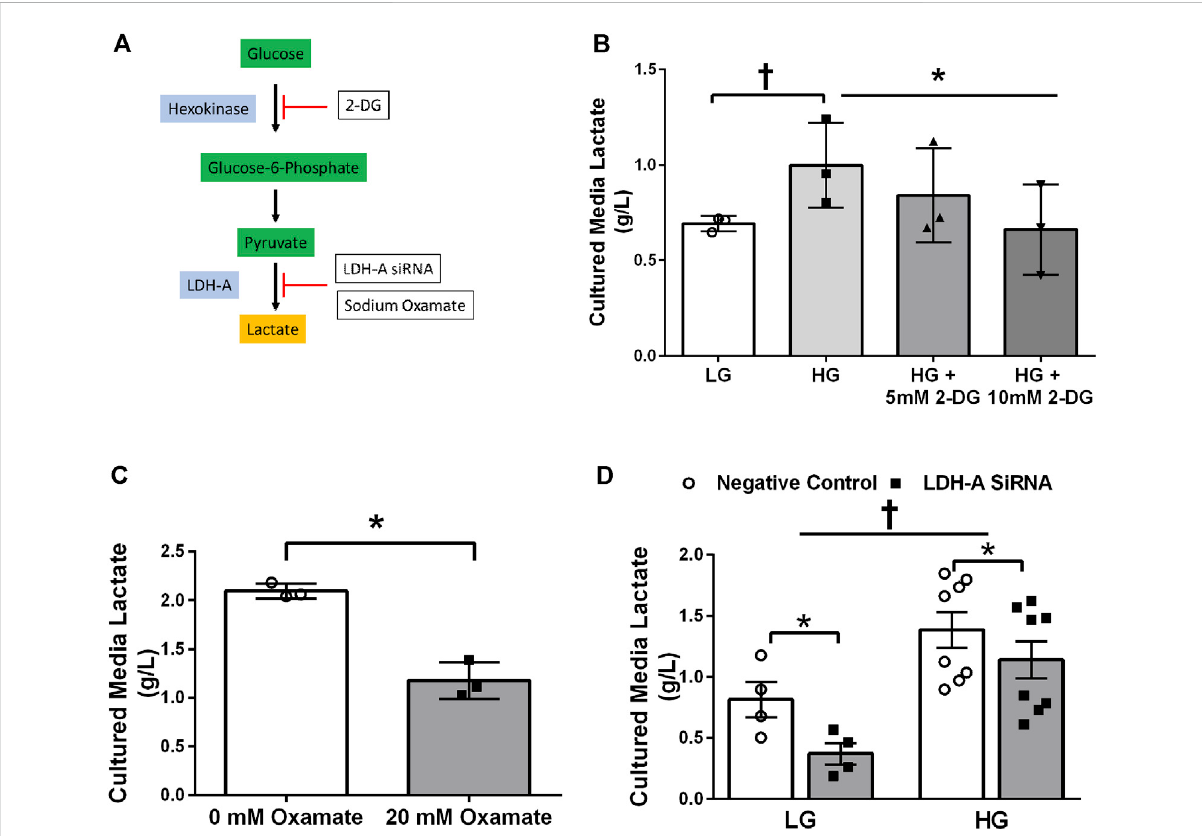
FIGURE 5 Culture Media Lactate Accumulation in Response to Glycolytic Intervention. Model of pharmacological and siRNA methodology to manipulate lactate accumulation (A) .Culturemedialactateconcentrations inresponse to 24 hlow glucose (LG,5.6 mmol/L)andhighglucose (HG, 20 mmol/L) treatment and in response to 24 h 2-DG treatment (n = 3) (B) . Culture media lactate concentrations in response to 24 h sodium oxamate treatment (n = 3) (C) . Culture media lactate concentrations in response to negative control (Silencer Select) and LDH siRNA under low glucose (LG, 5.6 mmol/L) and high glucose (HG, 20 mmol/L) treatment (n = 8) (D) . Lactate concentrations were presented relative to myotube protein concentrations per well. Data is expressed as mean ± SEM. * p < 0.05 main effect for inhibitory treatment; † p < 0.05 low glucose vs high glucose. Sample size (n) represents biological replicates from HSkMC derived from different